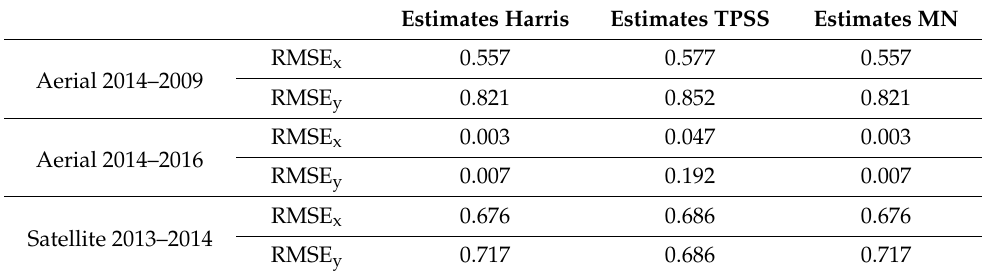
Table 6. Evaluation of the improved sub-pixel shift estimation using two optimization algorithms (TPSS: two-point step size, MN: Nelder–Mead). The unit of RMSE is pixels. Estimates Harris Estimates TPSS Estimates MN RMSE x 0.557 0.577 Aerial 2014–2009